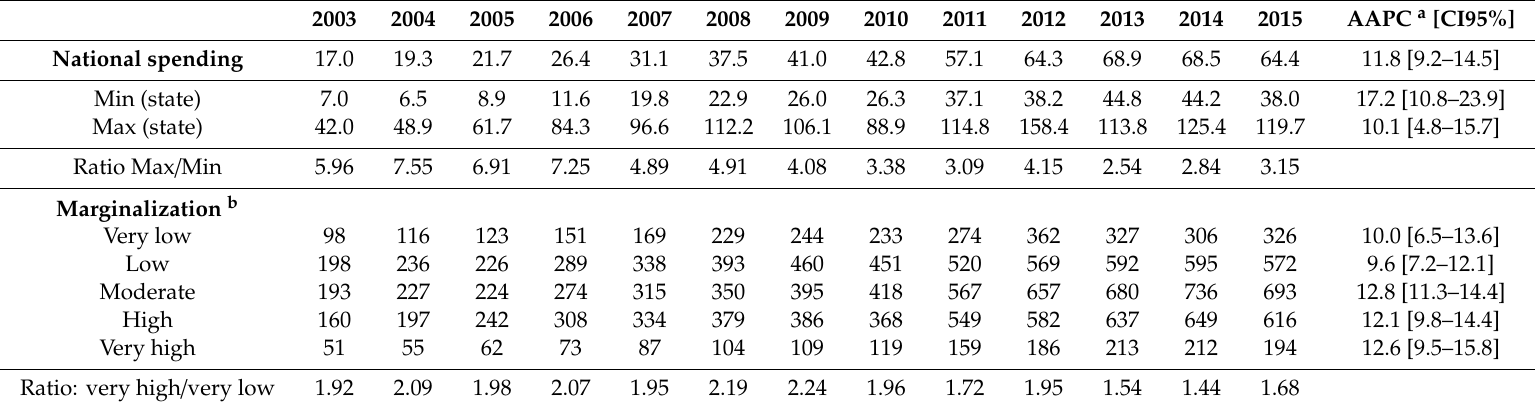
Table 2. Government MHFP expenditure per adolescent woman aged 10–19. States grouped by level of marginalization, Mexico, 2003–2015 ($ [PPP